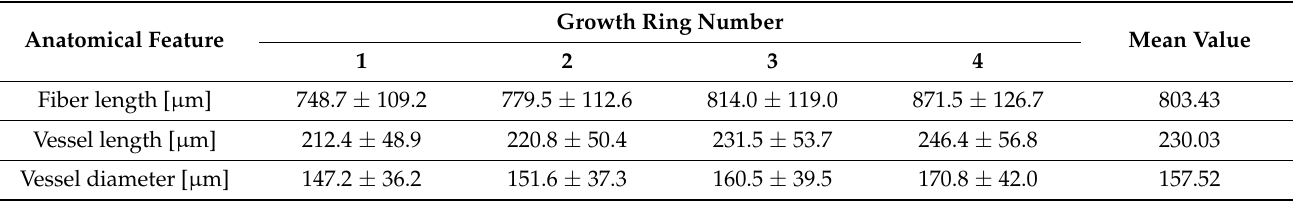
Table 2. Morphological features in the analyzed growth